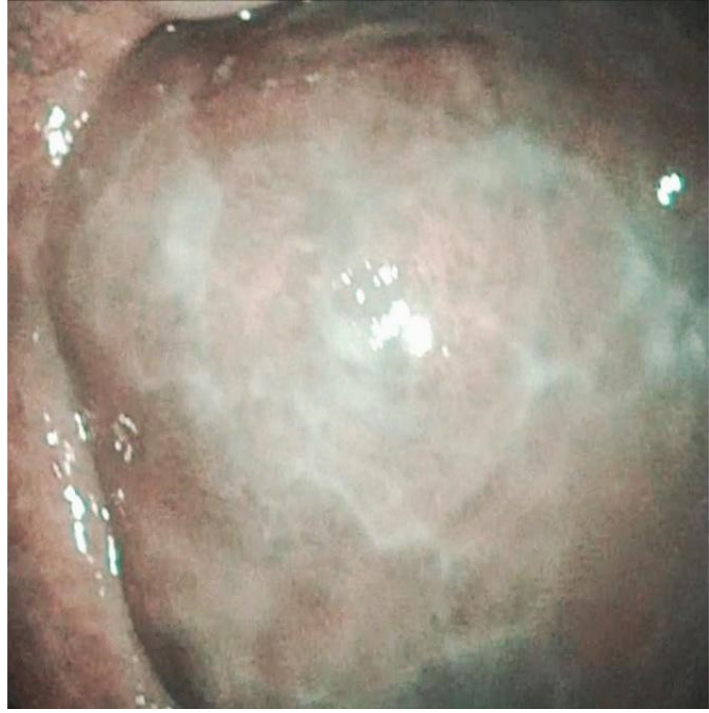
Figure 7. Lichenoid changes of the oral mucosa.